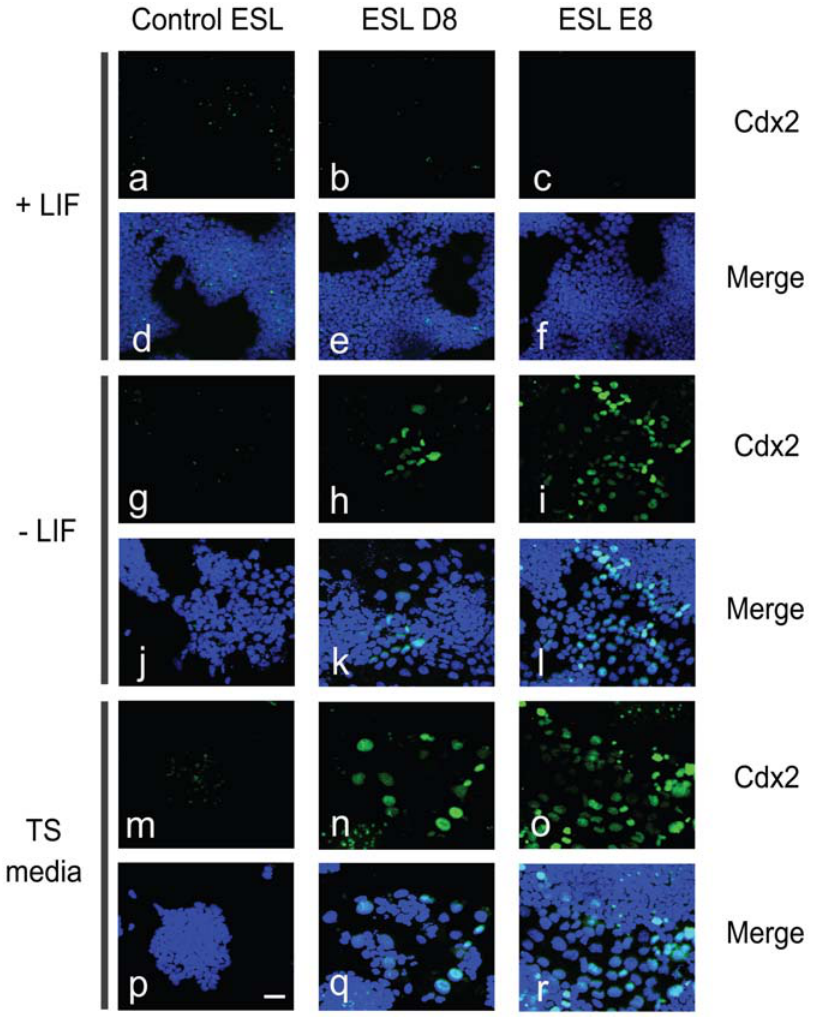
Figure 4. Withdrawal of LIF or cultured under TS cell condition promotes Mbd3 knockdown ES cells to differentiate towards trophectoderm lineage. Cdx2 staining of control or Mbd3 knockdown stable cells with or without LIF, or cultured under TS culture condition. (a–f) Cells were cultured in normal ES cell condition with LIF; (g–l) Cells were withdrawal of LIF for 4 days; (m–r) Cells were cultured under TS culture condition for 6 days. Hoechst stains the cell nuclei. The scale bar represents 50 m